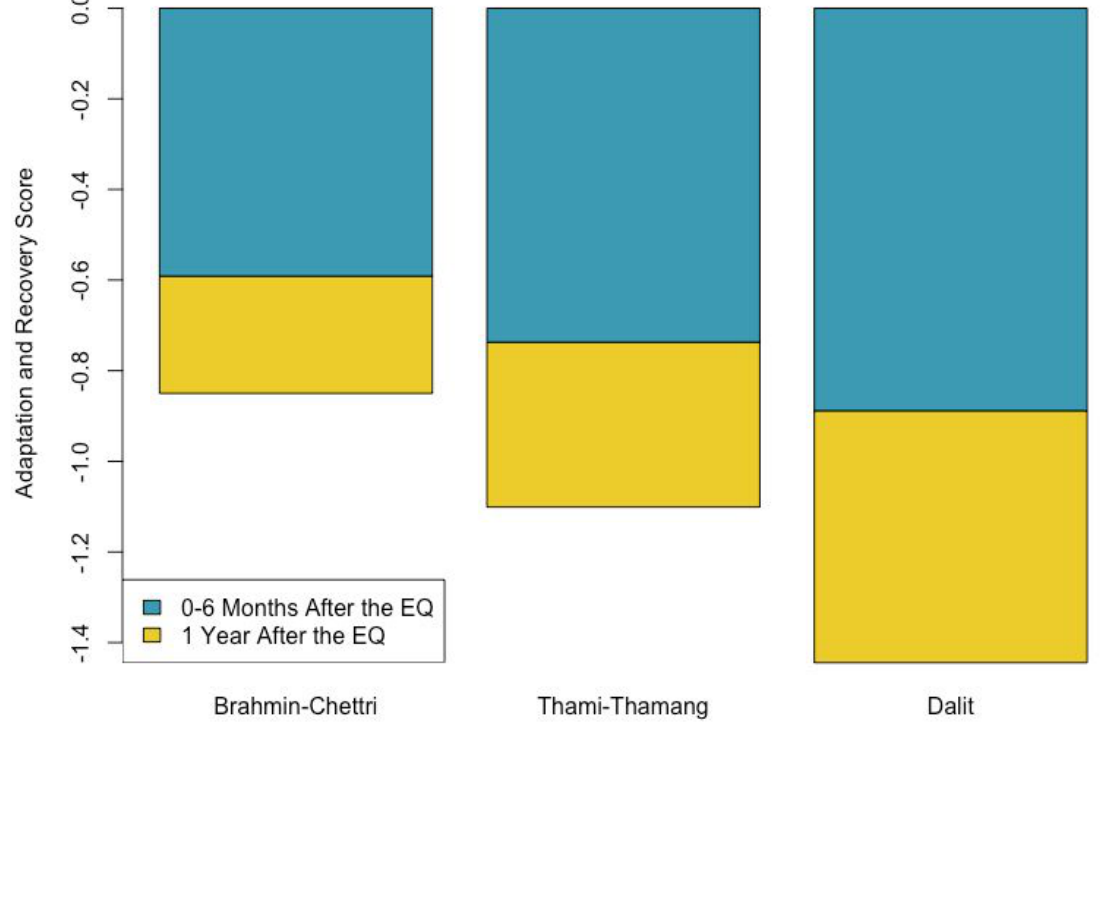
A4.2. Plot of ‘self-reliance’ ​ ​ ​ ​ ​ ​ ​ ​ EQ” and “1 Year After ​ ​ ​ ​ ​ ​ ​ ​ ​ ​